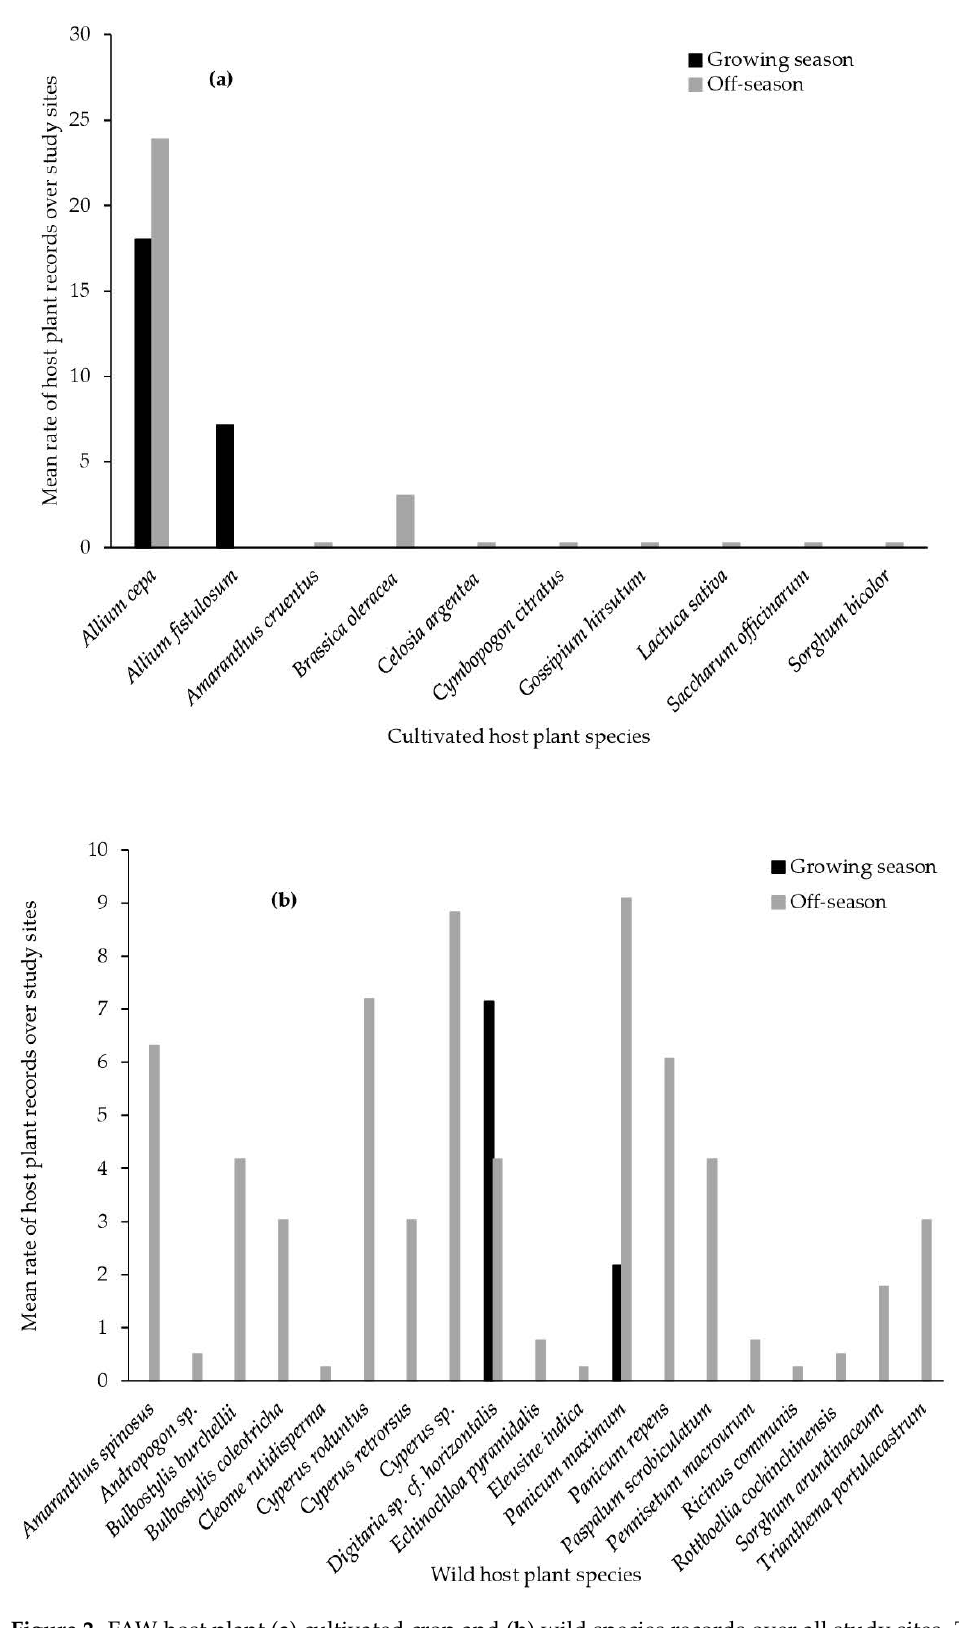
Figure 2. FAW host plant ( a ) cultivated crop and ( b ) wild species records over all study sites. The rate of host plant records for each study site is obtained by dividing the number of plants infested with FAW by the number of sites